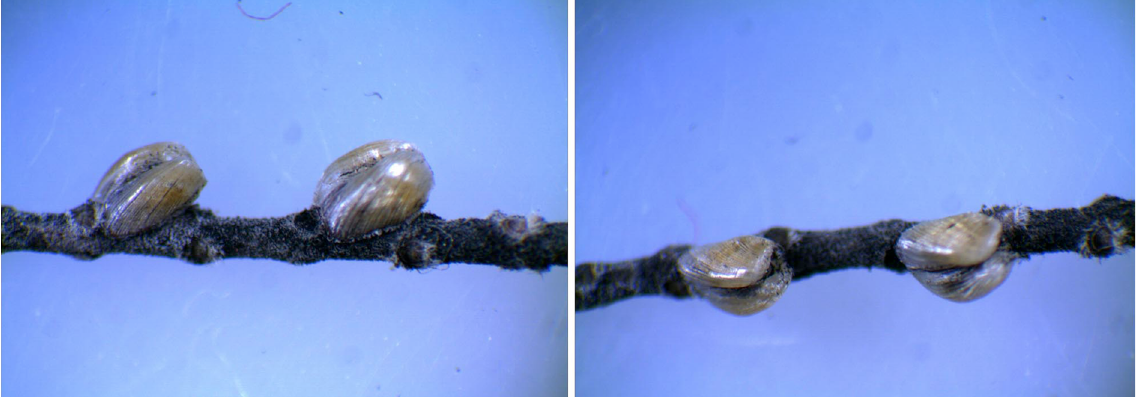
Fig. 5. Cryptinglisia millari Gavrilov-Zimin sp. nov., adult females in